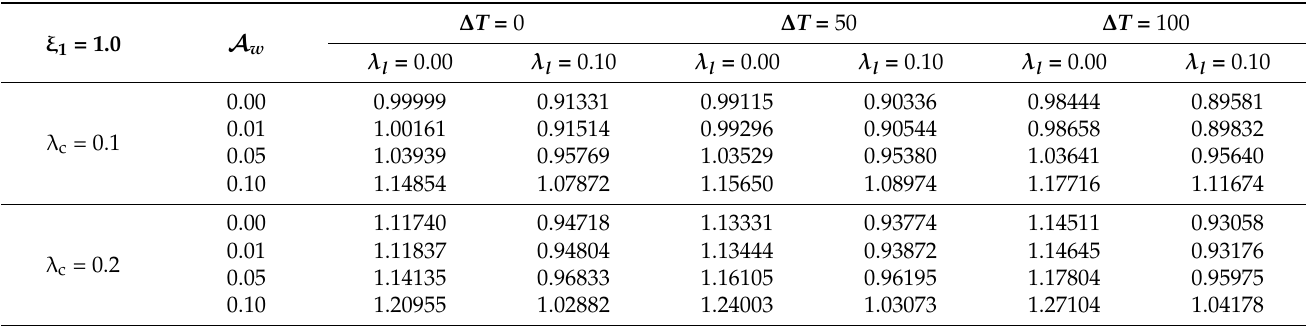
Table 14. Nonlinear dimensionless natural frequencies of porous FG clamped–clamped (C–C) nano- beam for ξ 1 = 1.0 in the case of Second-Order Hamiltonian Approach.